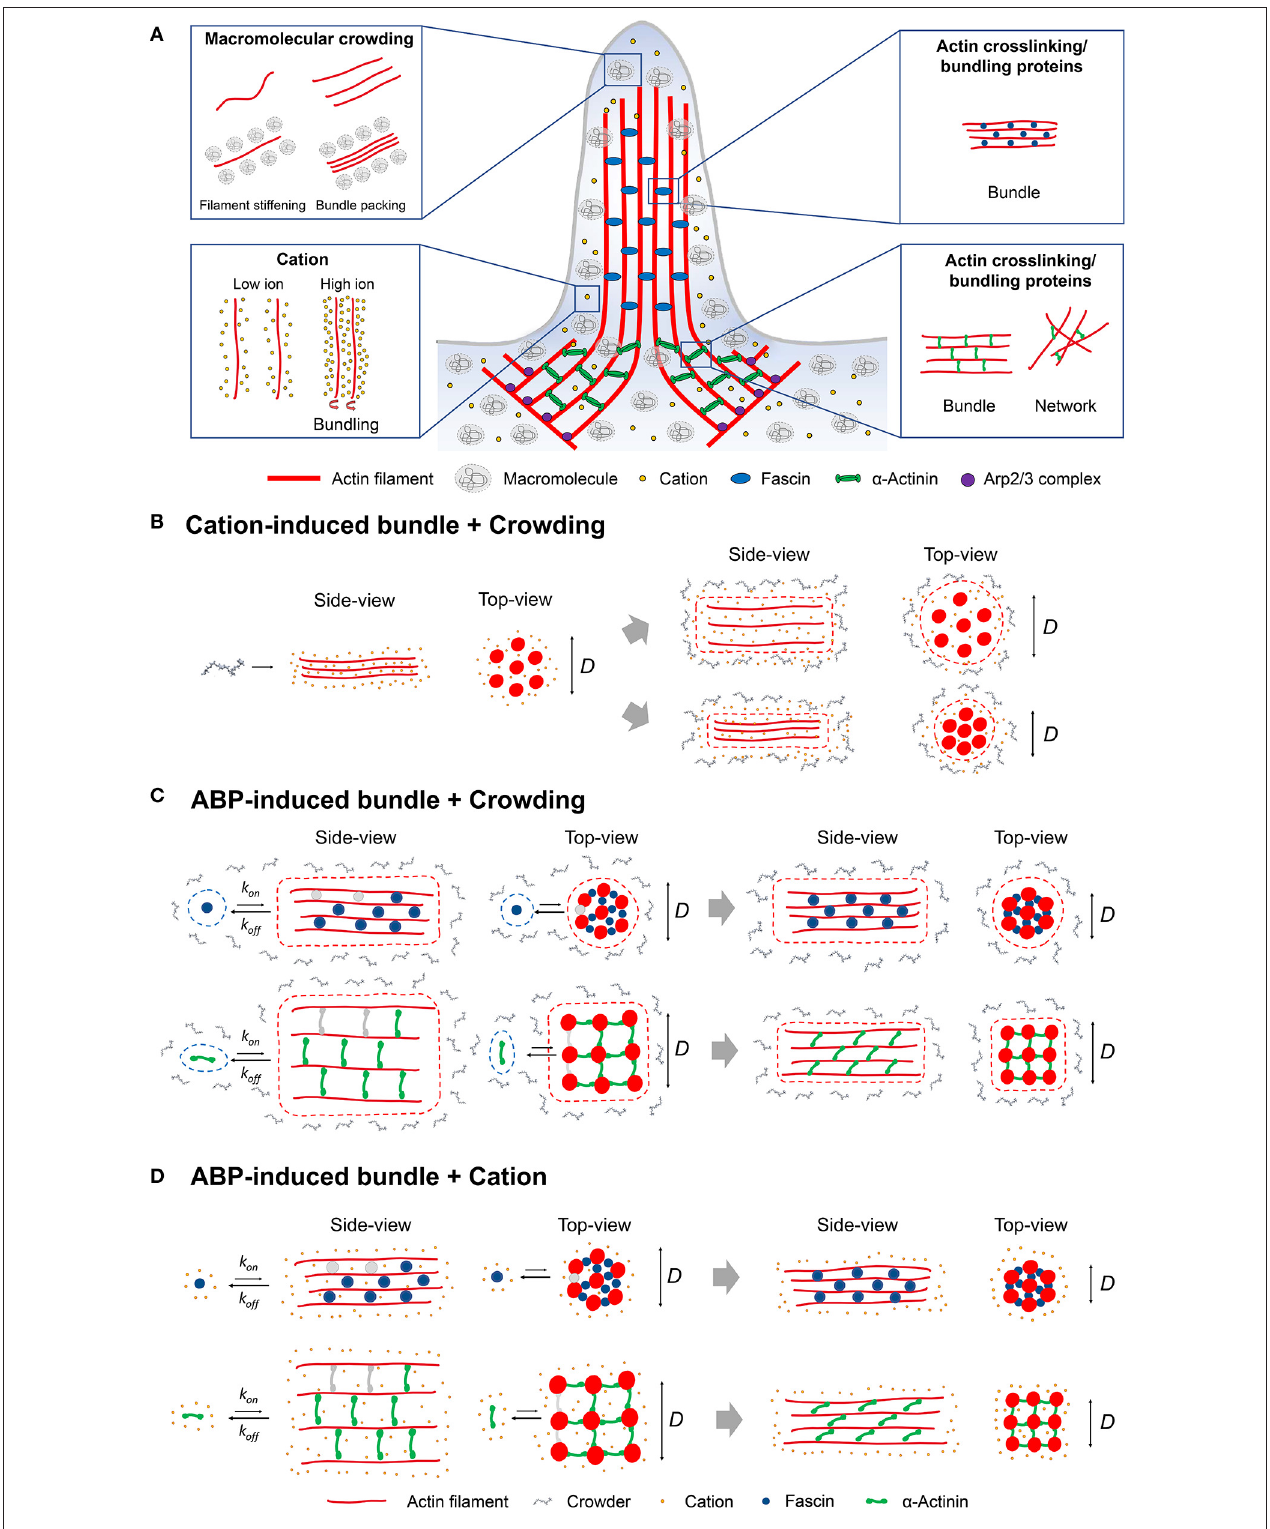
FIGURE 1 | (A) Schematic representation of the various intracellular factors such as macromolecular crowding, cation interactions, and actin-crosslinking/bundling proteins (fascin or α -actinin) that can induce actin bundling at the leading edge of a cell. (B) Cation-induced actin bundle formation in the presence of macromolecular crowding. Potential interactions between cations and crowding may affect the organization of bundles with a different bundle diameter ( D ). (C) Bundles induced